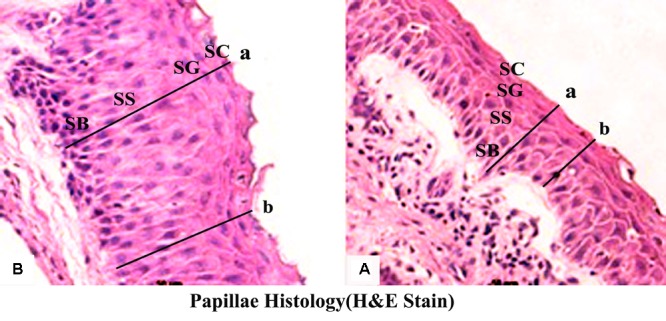
Effect of ruminal butyrate infusion on rumen papillae histology. Goats were infused by 0.1 M potassium phosphate buffer (50 ml) with sodium butyrate at 0.3 (B = butyrate group, n = 12) or 0 (A = control group, n = 12) g/kg of BW per day for 28 days. Histomicrographs showing epithelial strata at maximum (a) and minimum (b) depths in epithelium of goats. Morphological characteristics of the ruminal papillae observed by using Image-Pro Plus 6.0 (Media Cybernetics Inc., Bethesda, MD, United States).